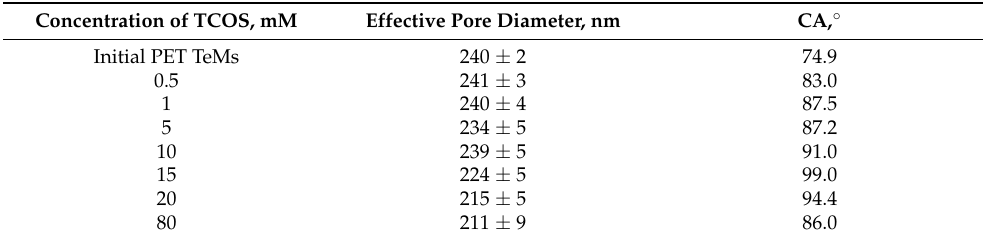
Table 1. Change in pore diameters and contact angle of the membrane dependence on the concentra- tion of TCOS (time is 24 h).